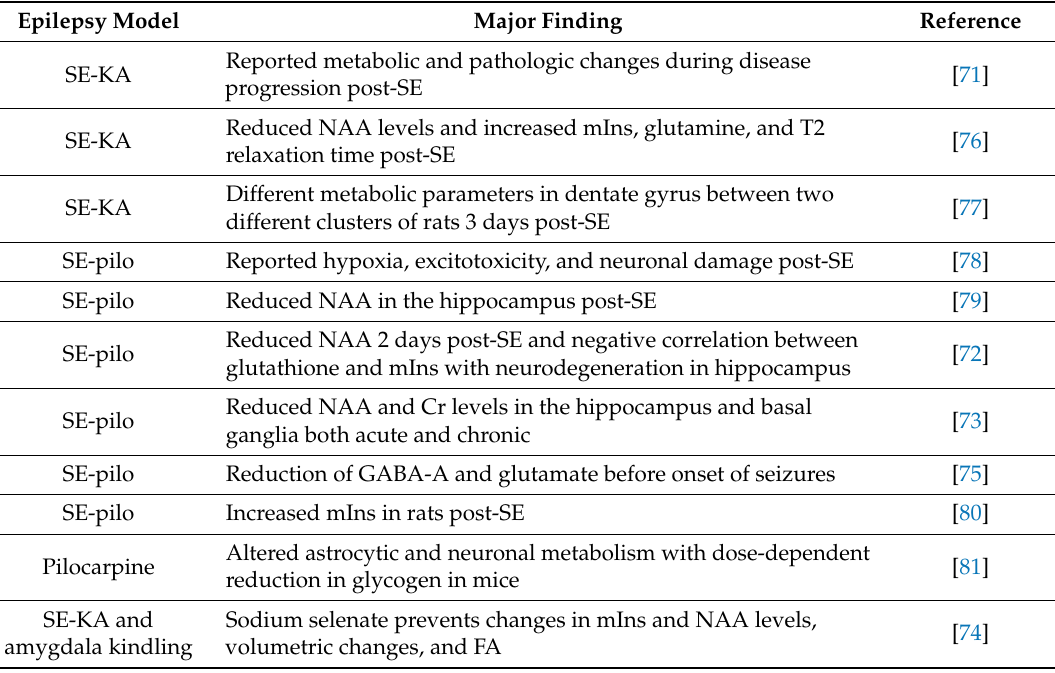
Table 7. List of MR spectroscopy (MRS) studies and potential biomarkers for